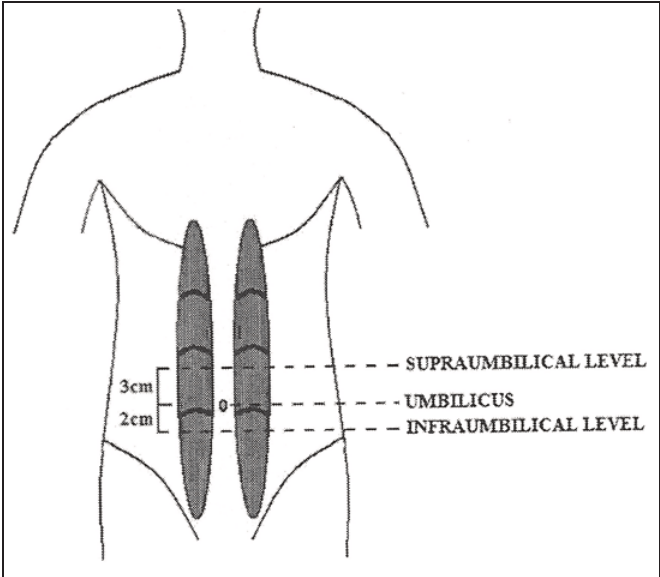
FIGURE 1 – Sites from which fragments of the rectus abdominis muscle were collected for